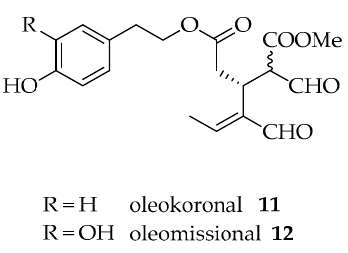
Figure 3. Chemical structures of oleokoronal and oleomissional.